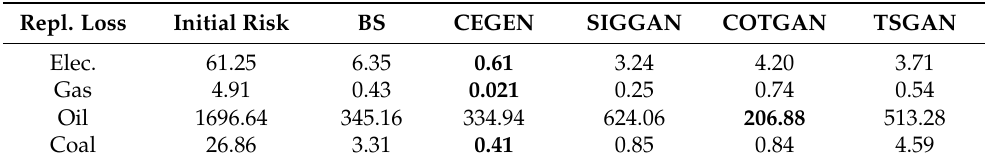
Table 2. Replication losses of deep hedgers trained on synthetic data for 3MAH forwards (French market). Bold values indicate best